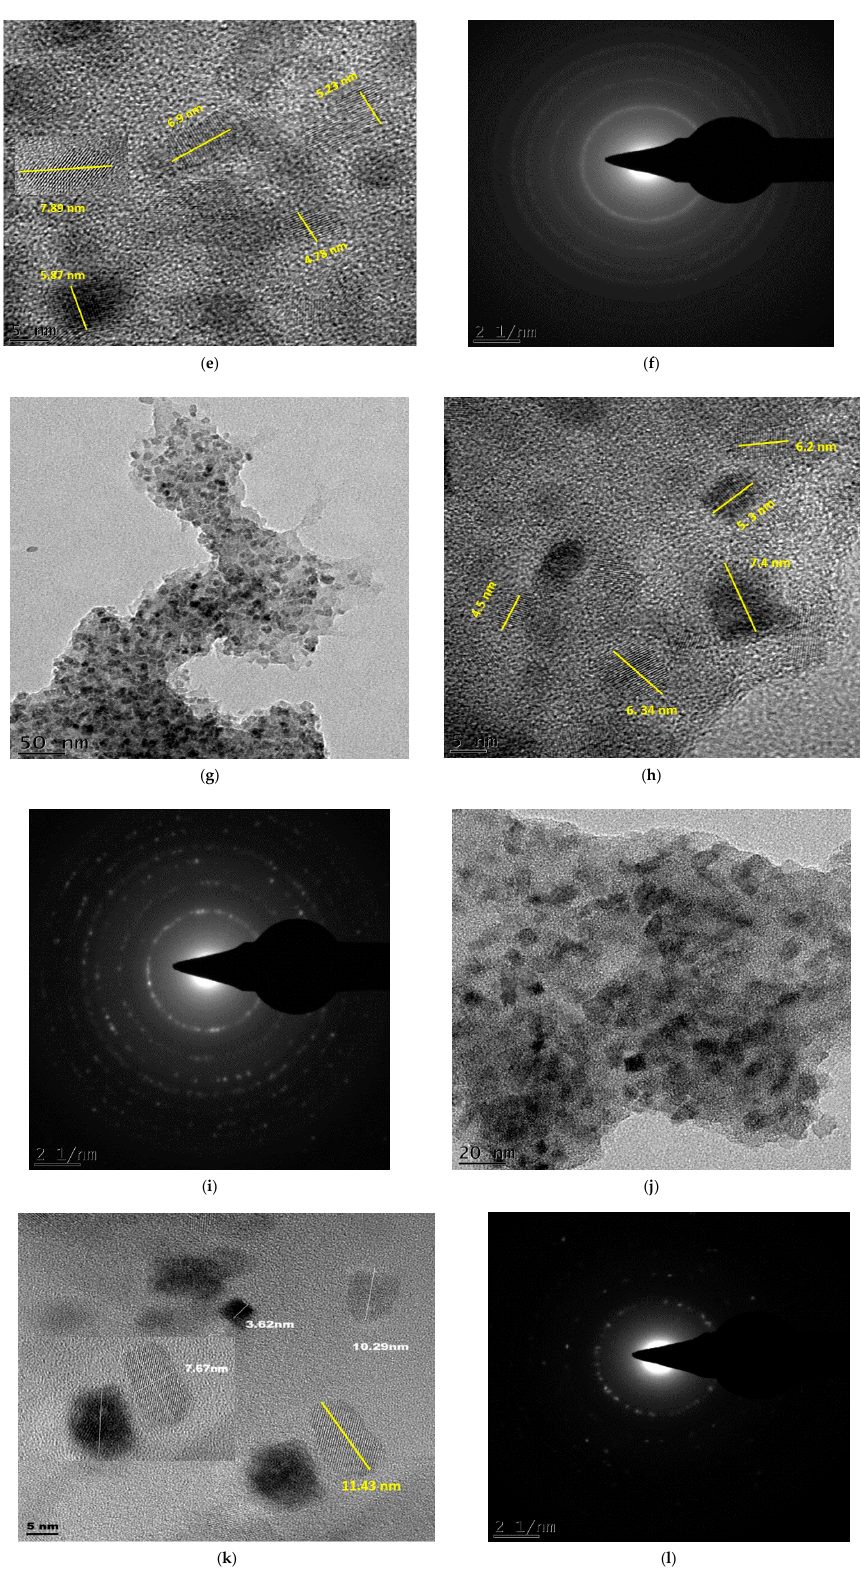
Figure 6. Bright-field micrographs and SAED patterns of ( a – c ) Degussa TiO 2 (S 0 ); ( d – f ) 105 min C–N–TiO 2 (S 1 ); ( g – i ) 120 min C–N–TiO 2 (S 2 ); ( j – l ) 135 min C–N–TiO 2 (S 3 ) pyrolysed at 350 °C at 50 °C/min ramping.